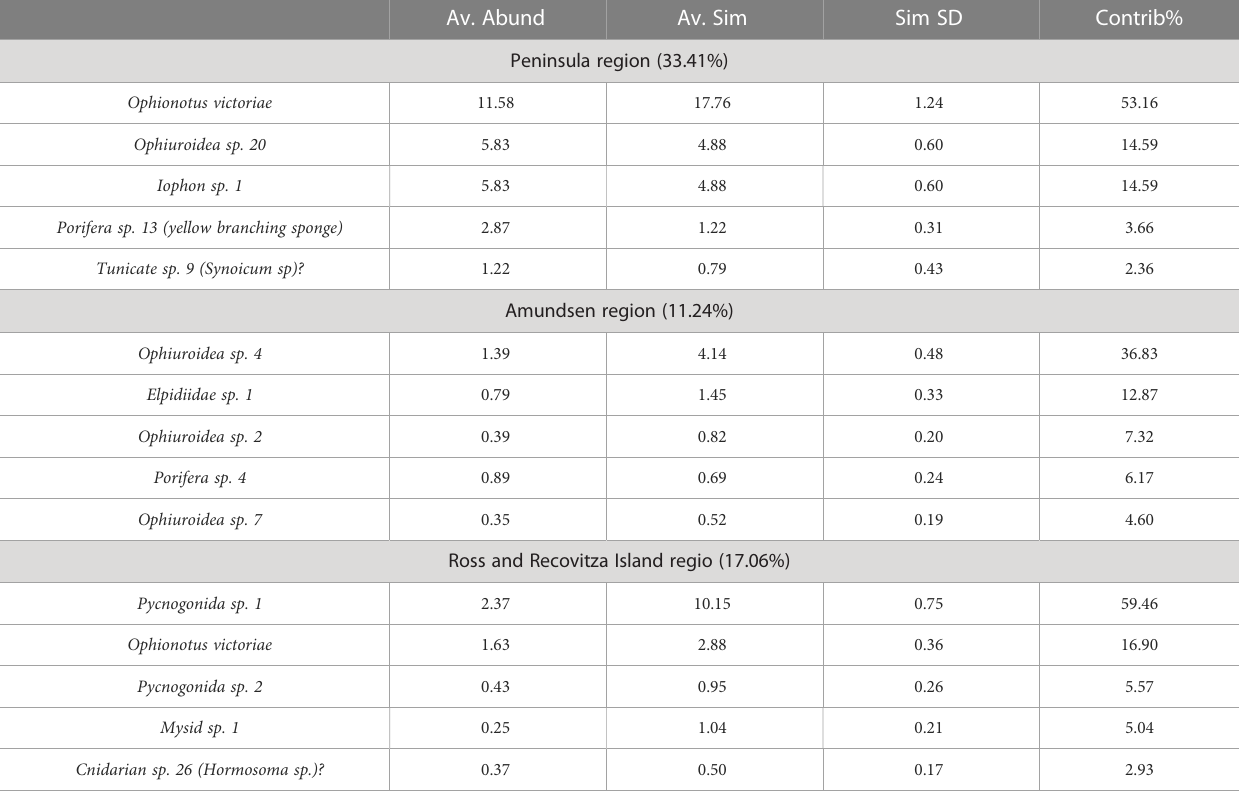
TABLE 2 Dominant 5 macrofaunal invertebrates based on SIMPER analysis for each region with average abundance (Av. Abund), average similarity within site (Av. Sim) including standard deviation (Sim SD), and percent contribution to the community (Contrib%).